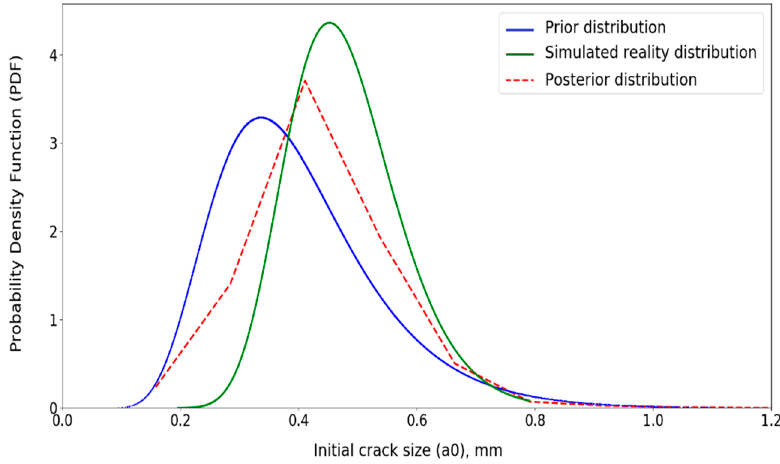
Figure 16. Updated distribution for initial crack size (a 0 )